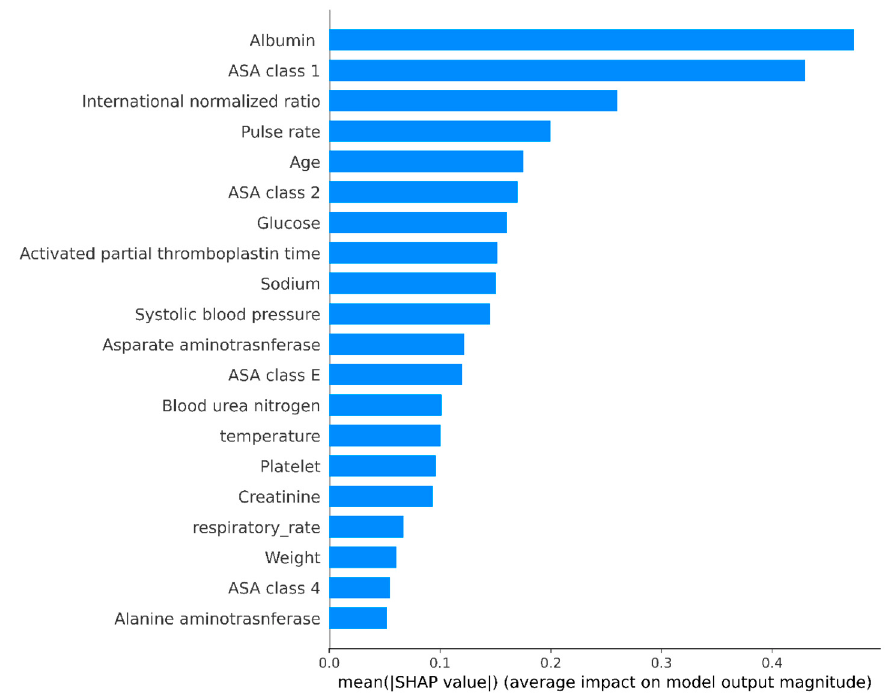
Figure 4. SHapley Additive exPlanations (SHAP) bap plot shows the importance of features in the prediction model by calculating the mean absolute SHAP value for each feature.